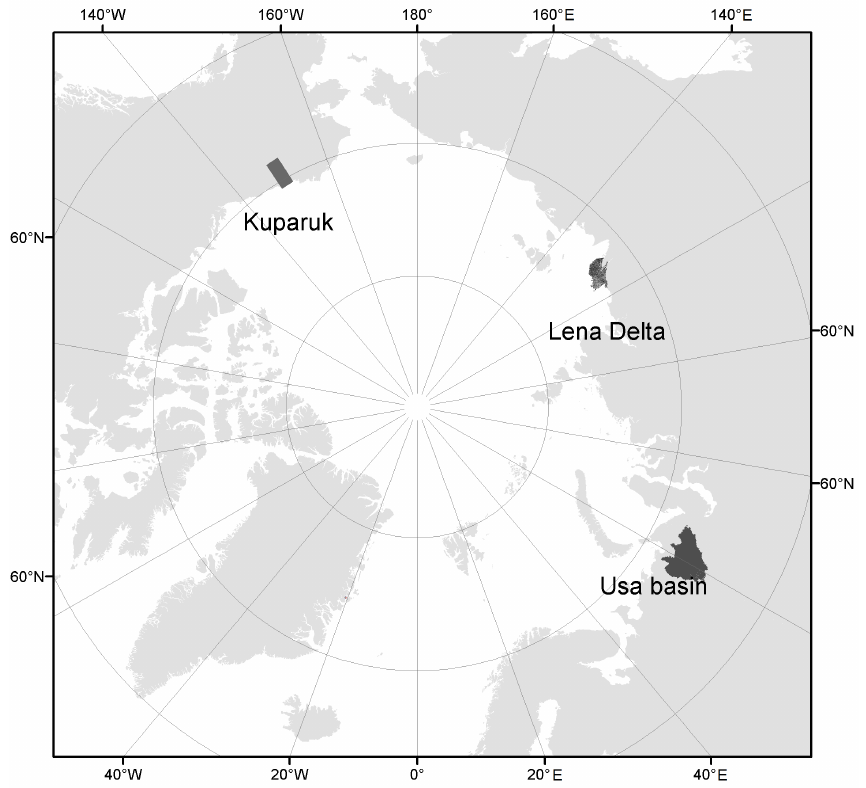
Figure 1. Location of the discussed sites with multi-purpose land cover maps from Landsat data. More details are provided in Table